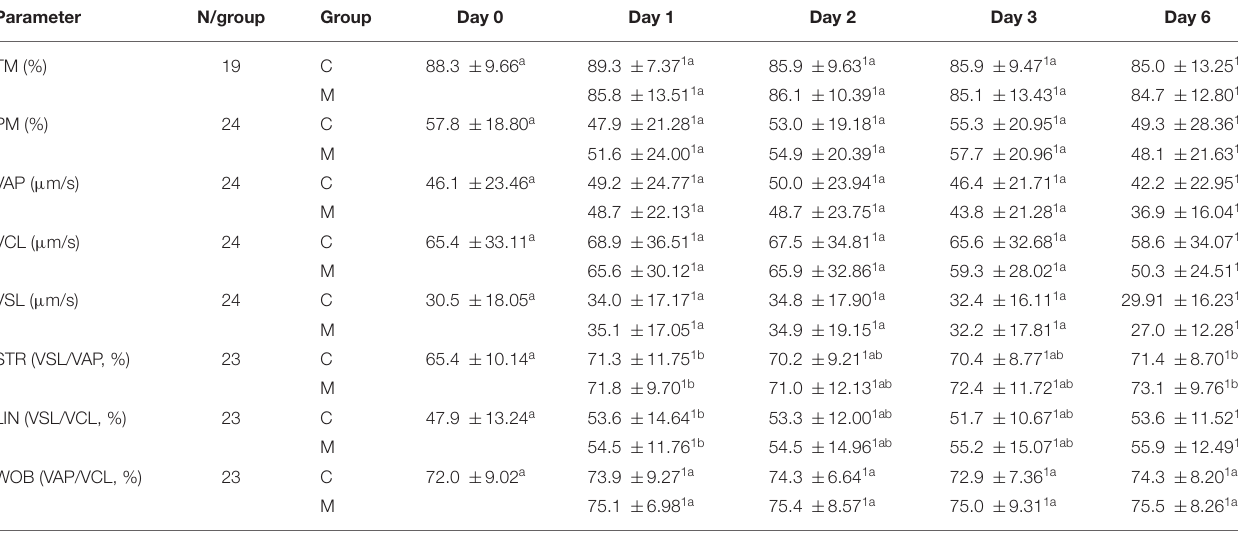
TABLE 1 | Results from CASA motility parameters from semen samples collected in increasing photoperiod during a cold storage period of 6 days.